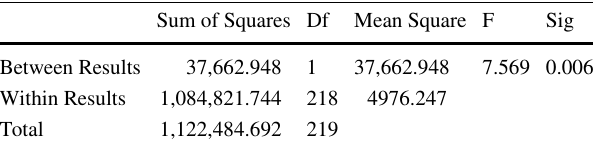
Table 9 Comparison between the Physiochemical and